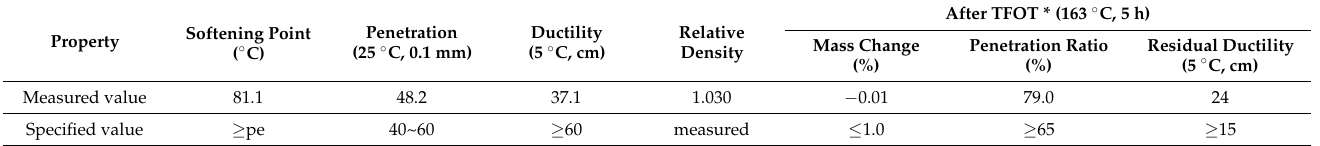
Table 1. Basic properties of SBS modified asphalt.